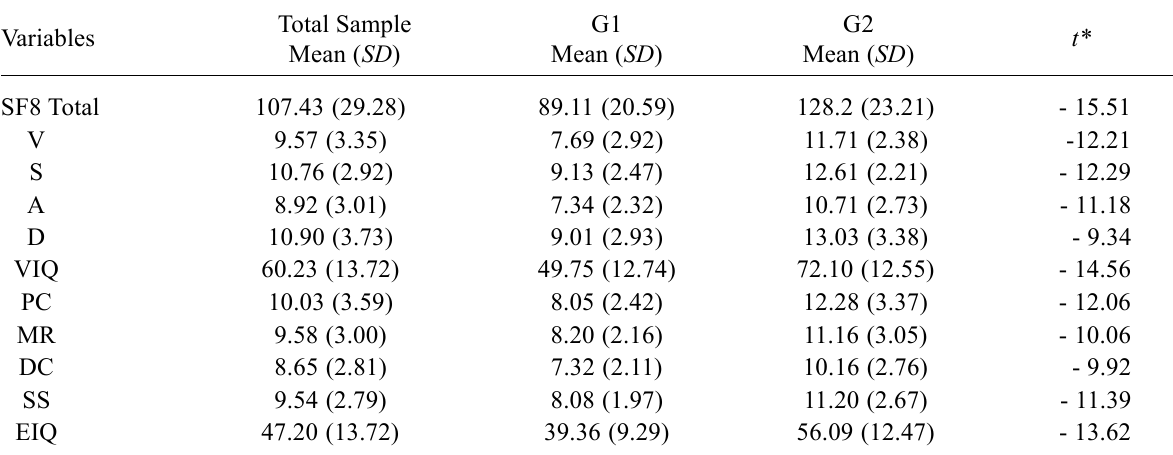
Cognitive Performance of the Total Sample and of the Groups With (G1) and Without (G2) Cognitive Decline